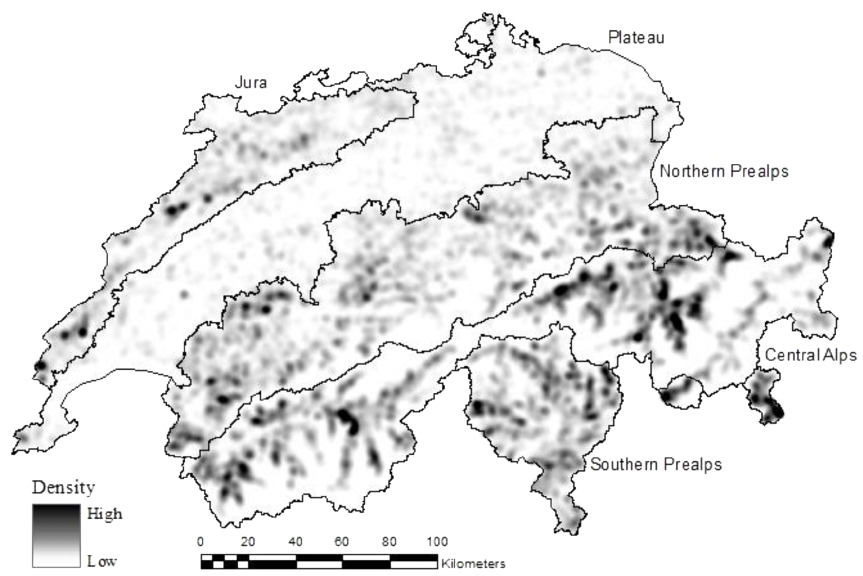
Figure A1. Spatial pattern of forest expansion. The pattern illustrates the density of forest expansion in Switzerland. The density was calculated including the area of all five transitions we used for calculating RF (see Sect. 2.3) and a kernel-density function in ArcGis 10.1